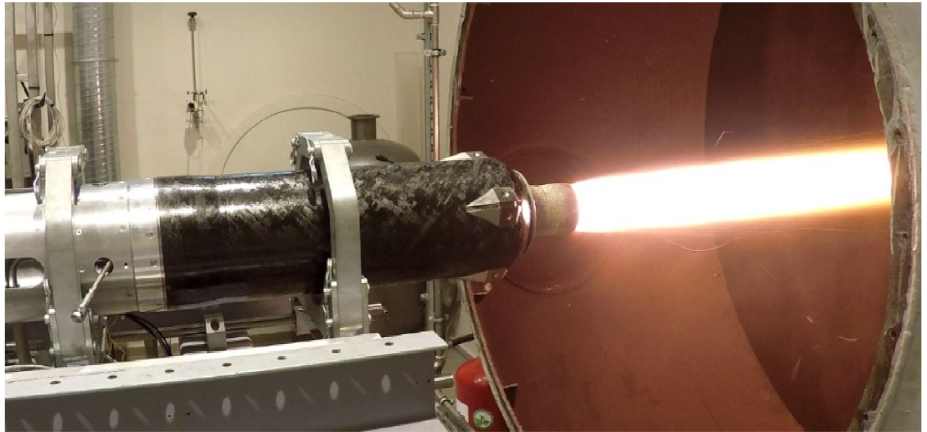
Figure 7. Sea level hot-firing of the full-scale hybrid rocket motor (Mk2018) of the ILR-33 AMBER rocket, using 98% HTP as oxidizer and HDPE as fuel.